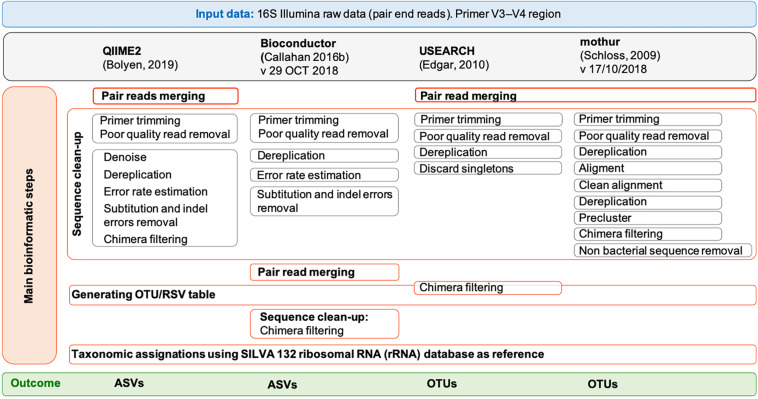
Overview of the pipelines used by free and open-source workflows: QIIME2, Bioconductor, UPARSE, and mothur. Each gray box represents a command of the pipelines. For UPARSE, chimera filtering is part of the OTU clustering step, and OTU taxonomic assignment was performed using mothur.